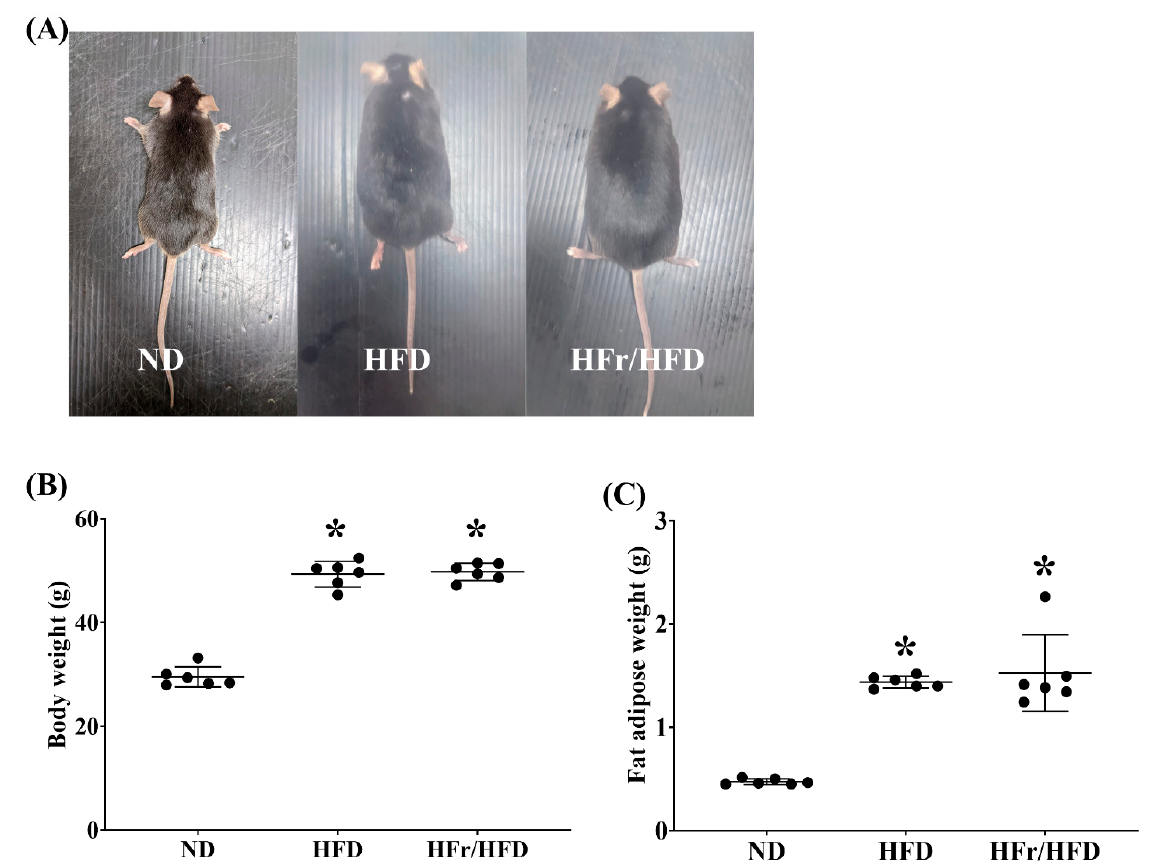
Figure 1. ( A ) Photographs of representative male C57BL/6J mice fed for 12 weeks with normal diet (ND), high-fat diet (HFD) and high-fructose/high-fat diet (HFr/HFD). ( B ) Comparison of mean body weight of the ND, HFD, and HFr/HFD groups. ( C ) Comparison of mean fat adipose weight of the ND, HFD, and HFr/HFD groups. Data were obtained from 6 mice in each group and presented as mean ± standard deviation. ND: normal diet group. HFD: the high-fat diet group. HFr/HFD: the high-fat diet plus 30% fructose in the drinking water group. * p < 0.05, versus the ND group.